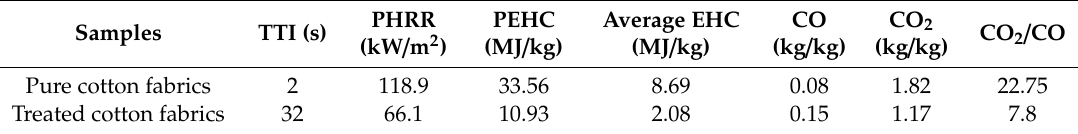
Table 3. Cone calorimetry test data of untreated and treated cotton